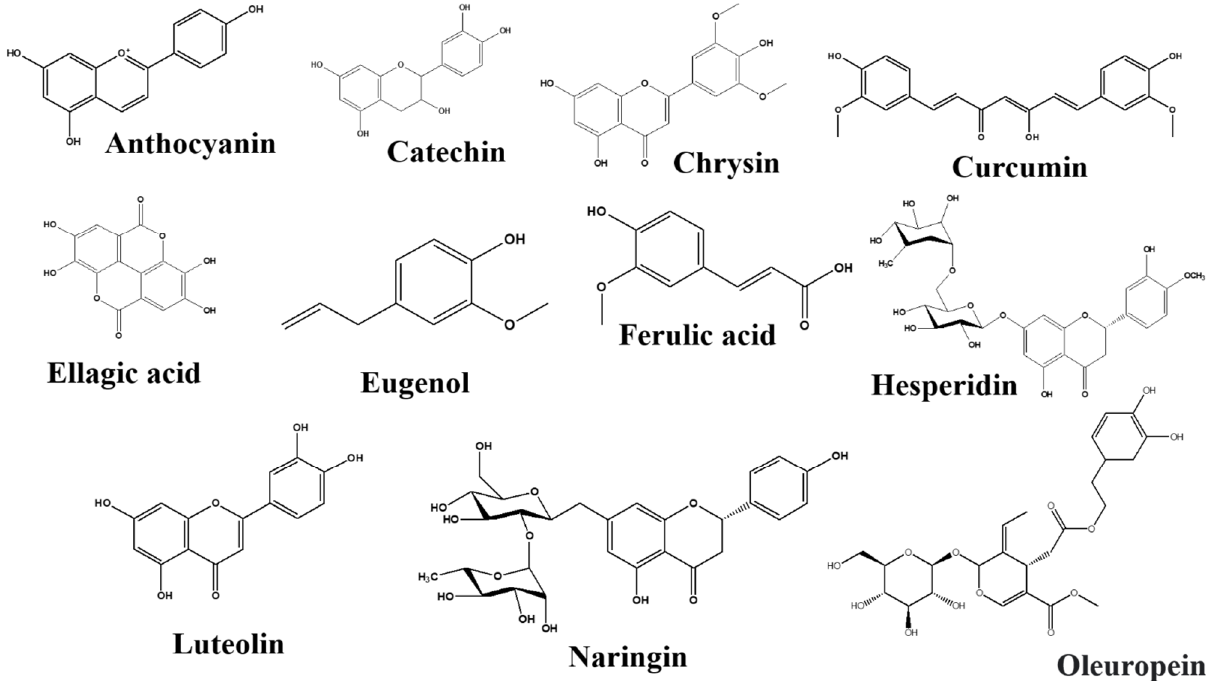
Figure 4. Structures of bioactive metabolites from natural products: Anthocyanin— Rubus fruticosus ; Catechin— Rhizophora mucronata ; Chrysin— Matricaria chamomilla ; Curcumin— Curcuma longa ; Ellagic acid— Punica granatum ; Eugenol— Syzygium aromaticum ; Ferulic acid— Ferula foetida ;